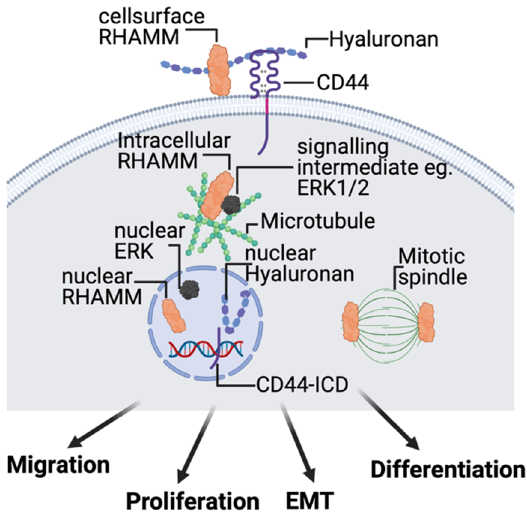
Figure 2. HA receptors CD44 and RHAMM regulate signaling that control skin cell migration, proliferation, plasticity, and differentiation during response–to–injury. CD44 is an integral membrane protein that coordinates signaling through growth factor receptors (e.g., EGFR) and cell surface RHAMM. The intracellular domain (ICD) of CD44, which can be released under injury conditions, forms part of transcriptional complexes that regulate expression of injury response genes. RHAMM also occurs in multiple intracellular compartments including the microtubule and actin cytoskeleton and, like CD44, is a component of transcriptional complexes regulating expression of extracellular matrix proteins that are required for wound repair. Created with BioRender.com (accessed on 12 September 2021).